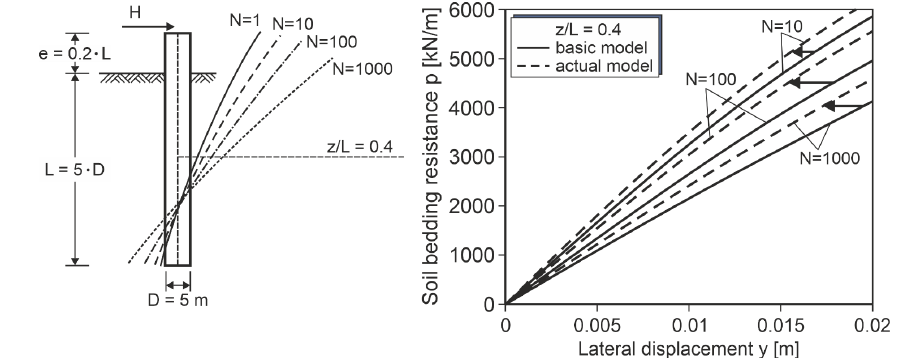
Figure 9. Exemplary comparison of p – y curves for constant horizontal displacement (bold lines) and p – y curves for the actual configuration (monopile in very dense sand).